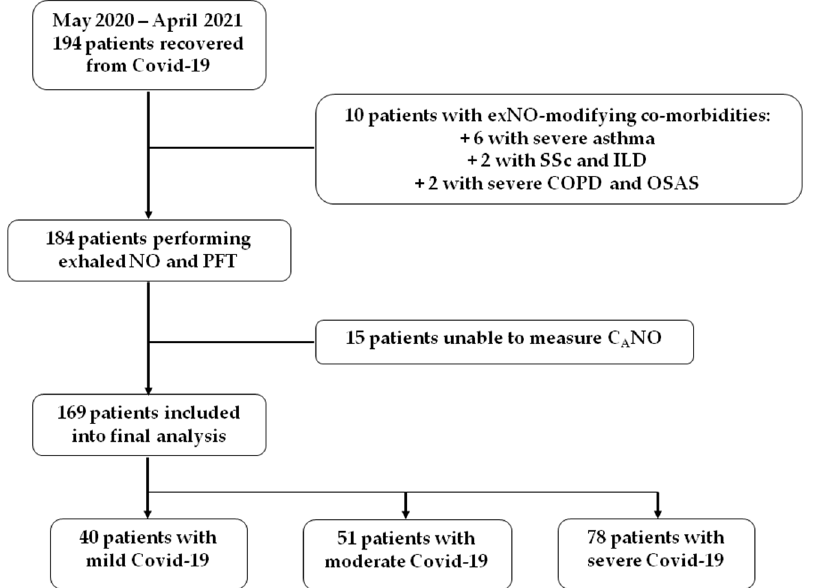
Figure 1. Patient recruitment, study, and final analysis. The patients were enrolled between 10 May 2020 and 9 April 2021 to perform the exhaled nitric oxide (exNO) and pulmonary function tests (PFTs) during routine surveillance after SARS-CoV-2 infection (COVID-19). SSc: systemic sclerosis; ILD: interstitial lung disease; COPD: chronic obstructive pulmonary disease; OSAS: obstructive sleep apnoea syndrome; CaNO: alveolar concentration of the exhaled nitric oxide.